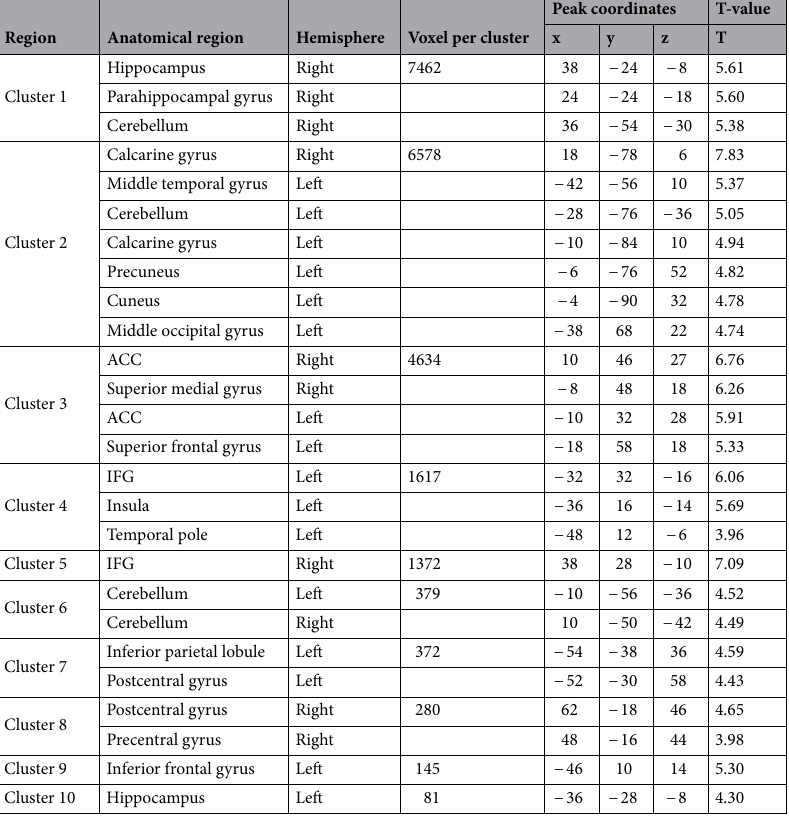
Table 1. Clusterwise statistics of the Contrast FUN > TYP. All reported regions were corrected for multiple comparisons on a cluster threshold of p < 0.05, voxel threshold p = 0.001, k = 47 voxel. Clusters which survived a FDR-correction are indicated by a + . Coordinates are reported in MNI space.